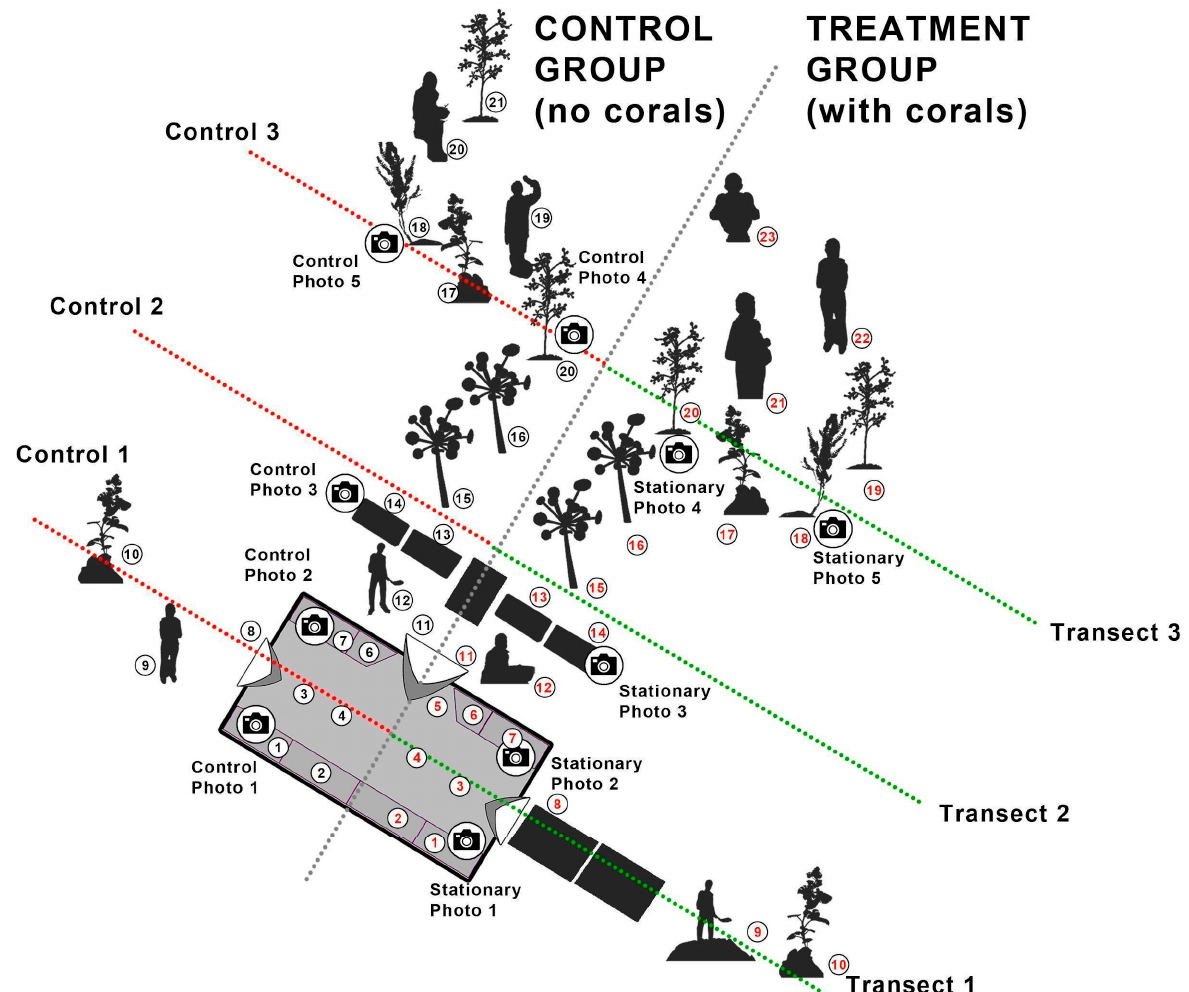
Figure 4. Coral Greenhouse layout showing sculpture locations, transect locations, stationary point photo locations and transplantation sites for treatment and control locations. Numbers in red are locations for coral planting and monitoring. Numbers in black are locations for control (no coral planting).